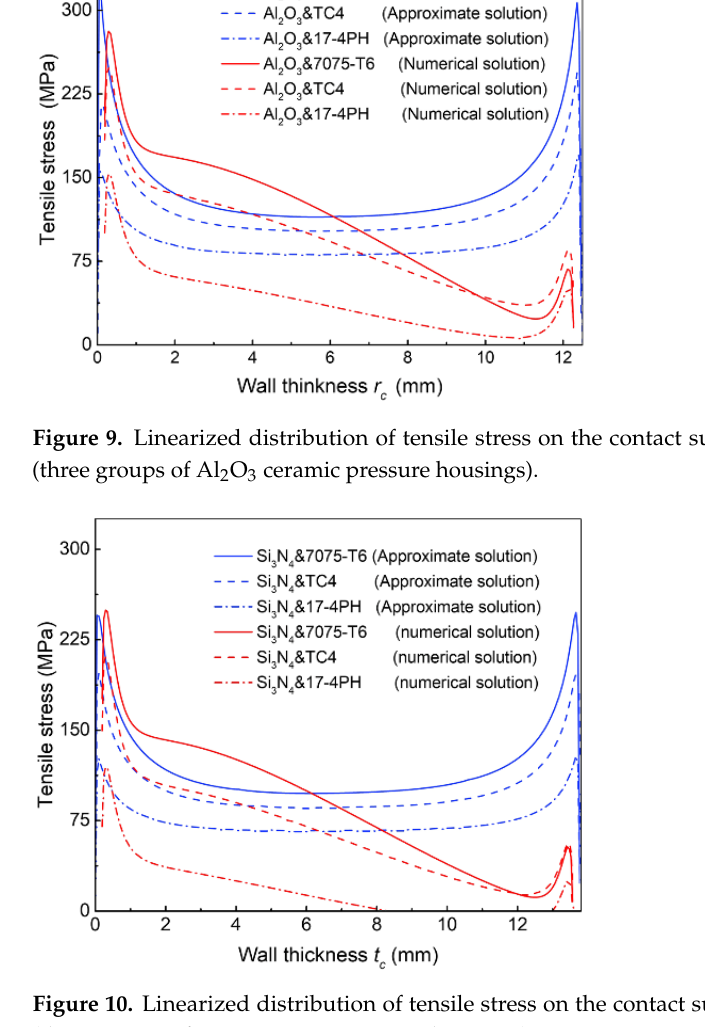
Figure 10. Linearized distribution of tensile stress on the contact surface along the wall thickness (three groups of Si 3 N 4 ceramic pressure housings).